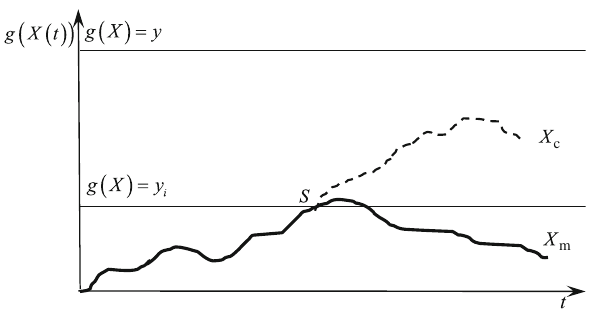
Fig. 2 Generation of an offspring response trajectory